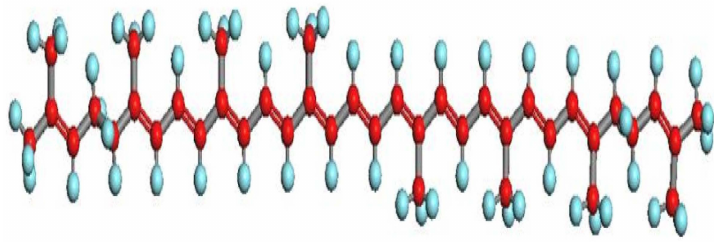
Figure 1. Structure of